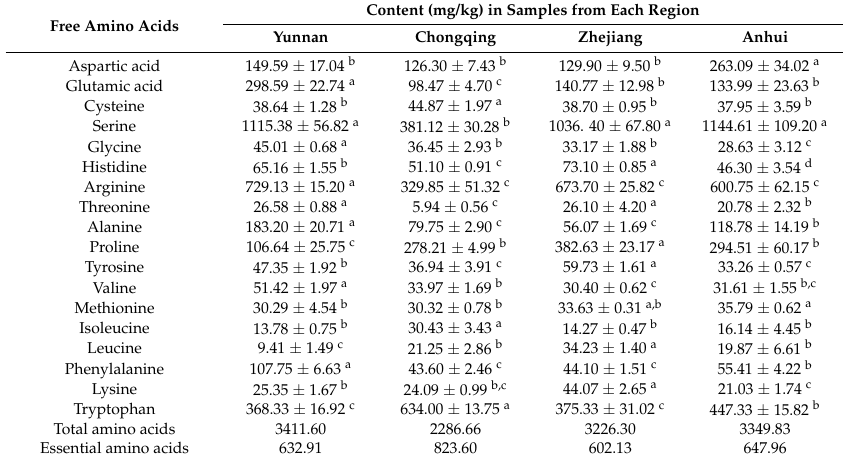
Table 1. Free amino acid content of the dried fruits of C. speciosa from four production areas. Content (mg/kg) in Samples from Each Region Yunnan